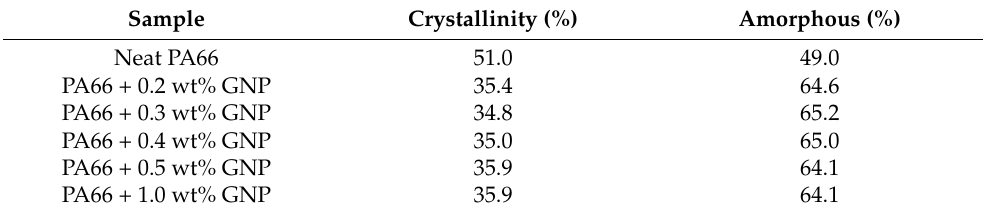
Table 6. Crystallinity degrees of neat PA66 and GNP/PA66 nanocomposites were calculated by the software.